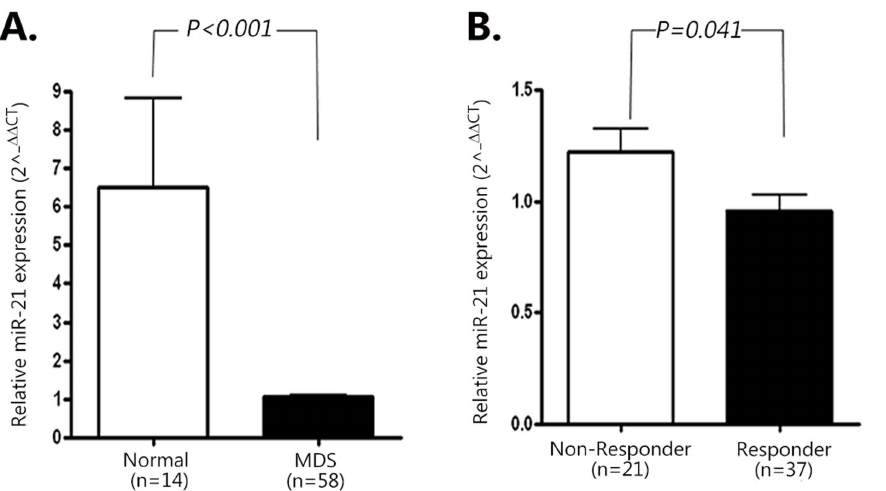
Figure 1. Expression and stability of reference gene candidates in the sera of healthy donors and patients with MDS. (A) Quantification (Ct) of candidate reference miRNAs (miR-192, miR-16, and miR-93) in serum samples of healthy donors and MDS patients corrected for efficiency and two interpolate controls are shown. Box plots represent lower and upper quartiles with the median depicted with a horizontal line. Whiskers depict the 10th and 90th percentiles. Differences in serum levels of candidate miRNAs were not found between healthy donors (white box), MDS patients prior to HMA therapy (gray box), and MDS patients treated with four courses of HMA therapy (black box). (B) Average expression stability values for candidate reference miRs in MDS patients, which were calculated by the geNorm algorithm, are shown as a bar graph and with actual values. High expression stability is indicated by a low stability value. MDS, myelodysplastic syndromes; miRNAs, microRNAs; HMA, hypomethylating agents.